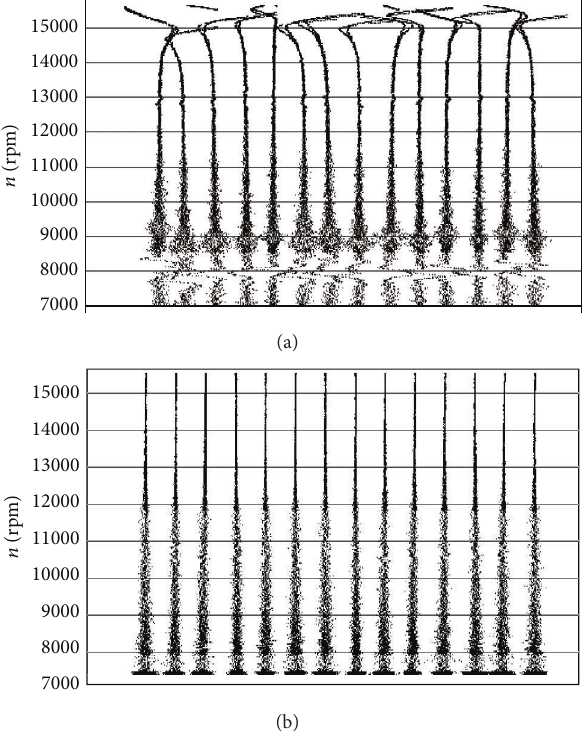
Figure 32: How foreign-matter depositions may affect the level of stress in the SO-3’s 1st stage compressor blades [55]: (a) effect of foreign matter in compressor inlet; (b) model amplitude-phase spectra of the 1st compressor